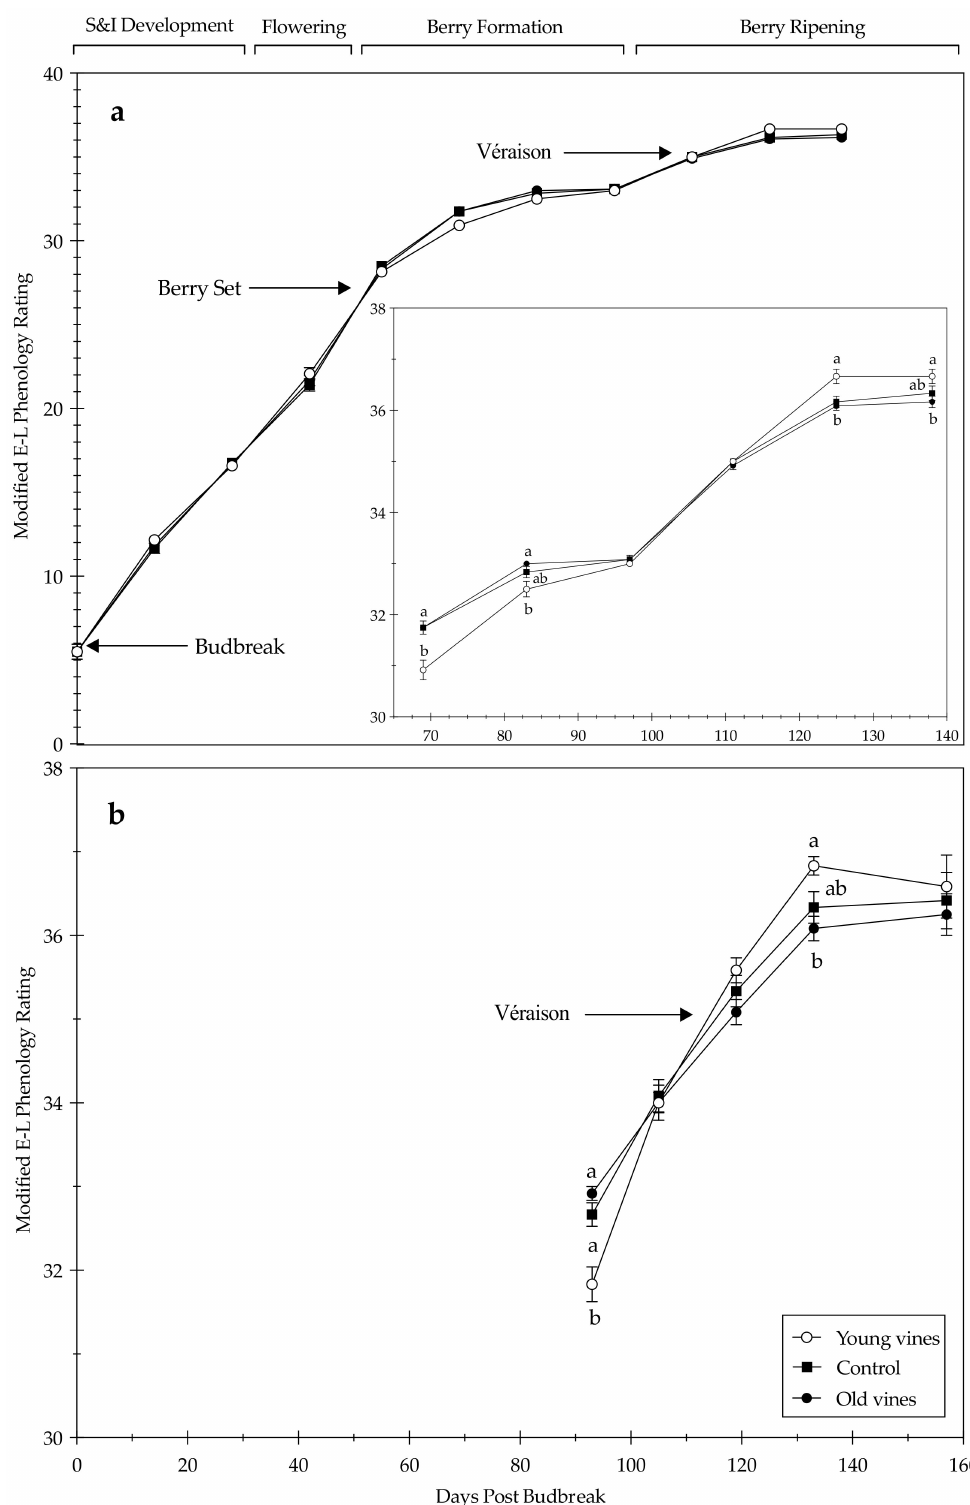
Figure 2. Phenology tracking during the ( a ) 2020 and ( b ) and 2019 growing season ( n = 12). One-way analysis of variance (ANOVA) showing treatment means, with bars representing the standard error of the mean. Different letters indicate differences between treatment groups based on Tukey HSD. Graph inset enlarged the 2020 data from two weeks post-berry set to four weeks post-v é raison. Key phenological stages (budbreak, berry set, and v é raison) and general growth labels (shoot and inflorescence development, flowering, berry formation, and berry ripening) are marked based on the Modified Eichhorn-Lorenz (E-L) system. S&I development corresponds to shoot and inflorescence